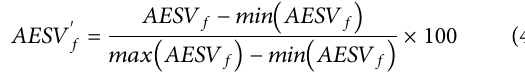
Frontiers in Environmental Science |